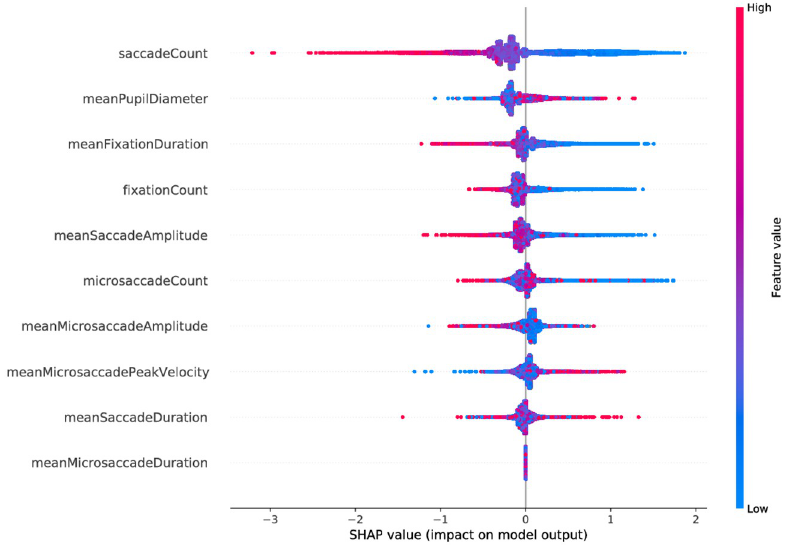
Fig 4. Summary plot of the approx. Shapeley values, that is, the density of the marginal contributions of the features in the GBDT model that uses only the eye-movement features. Red denotes high feature values, whereas blue indicates low feature values, and grey show categorical values or missing values that cannot be assigned a feature